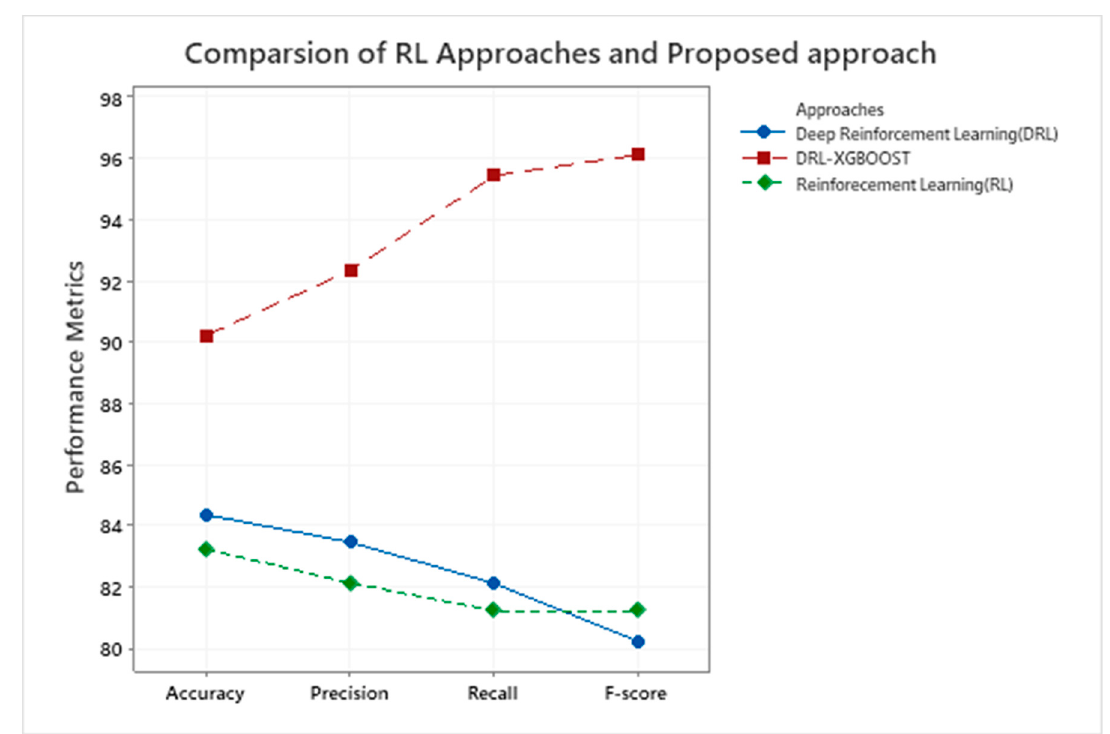
Figure 5. Illustrate the performance metrics for the RL technique and